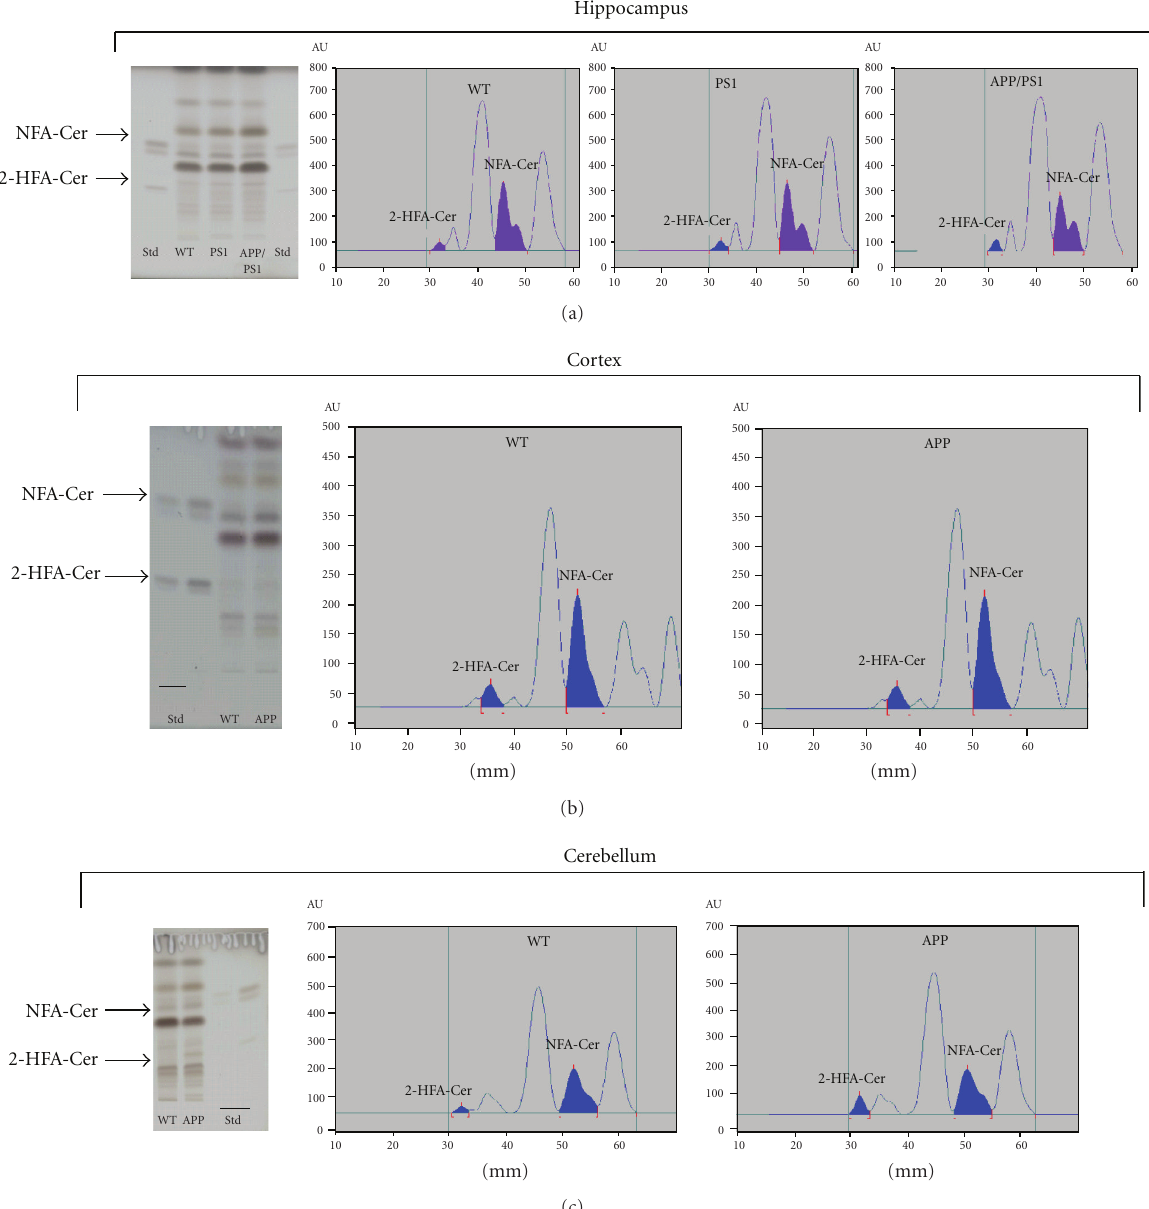
Figure 3: Typical HPTLC profiles of ceramides from hippocampus of 12-month-old APP SL /PS1 M146L , PS1 M146L , and their age-matched wild- type (WT) control mice (a), and from cerebral cortex and cerebellum of 24-month-old APP SL mice and age-matched WT control ((b) and (c), resp.). The densitometric analyses of the HPTLC plates were shown in parallel, respectively. Std: a mixture of standard NFA-ceramides and 2-HFA-ceramides. Ceramides were developed on HPTLC plates with chloroform-methanol (50: 3) and located by spraying the plate with copper acetate 3% in H 3 PO 4 8% reagent, followed by heating. Both 2-HFA-Cer and NFA-Cer appear as two bands corresponding to long-chain ceramides ( ≥ 22C; upper band) and short-chain ceramides ( ≤ 18C; lower band). Quantitative evaluation of ceramides was performed by scanning the plate at 396 nm with the Camag TLC Scanner 3/WinCats software